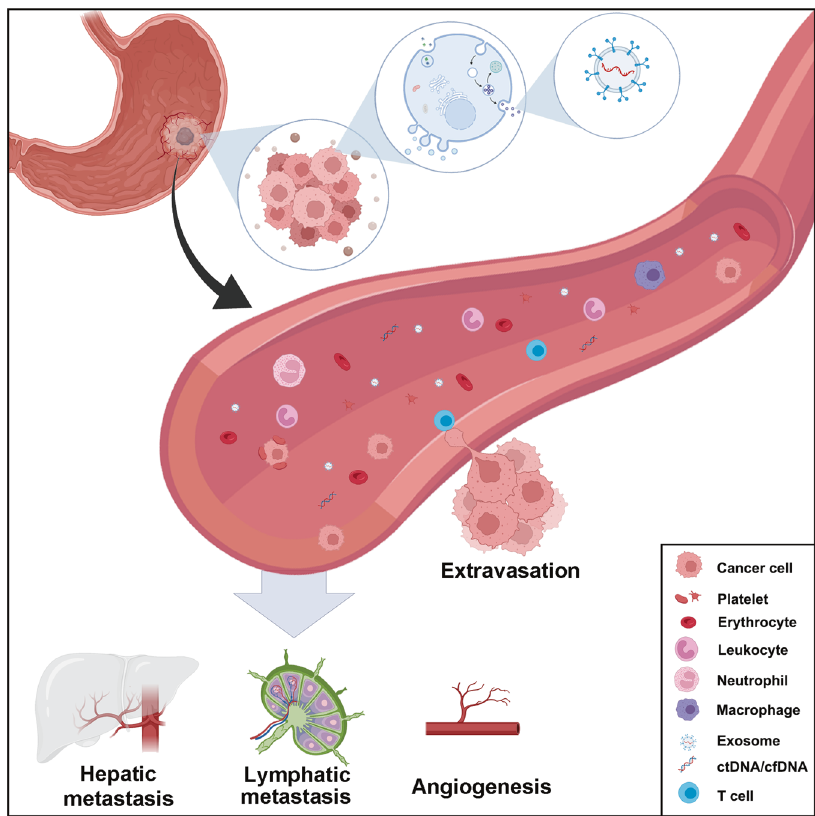
Fig. 2 Components of liquid biopsy in GC. CTCs, ctDNA, and exosomes were discovered in the peripheral blood. CTCs and ctDNA are important ingredients that are usually regarded as the foundations of liquid biopsy. ctDNA is formed from apoptotic and necrotic tumor cells, which release fragmented DNA into the bloodstream and possess genetic aberration from original tumor cells. CTCs are cancer cells that spontaneously shed from primary or metastatic tumors and circulate in the circulation. They are tumor “ seeds ” and can result in recurrence by hepatic metastasis, lymphatic metastasis, and